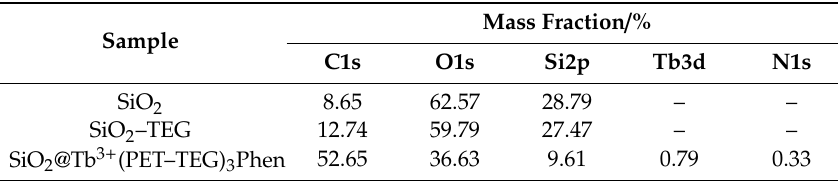
Figure 2. X-ray photoelectron spectroscopy (XPS) spectra of C1s deconvolution curves for ( a ) SiO 2 –TEG and ( b ) SiO 2 @Tb 3+ (PET–TEG) 3 Phen. Table 2. Atomic percentage of elements on sample surface.